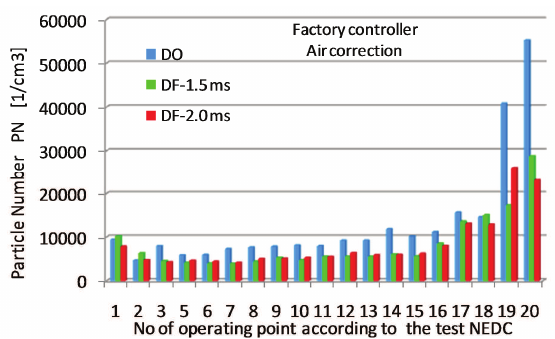
Fig 9. Comparison of total number of particulate matter (PN) in exhaust gases of Fiat 1.3 MJT engine fueled traditionally and in dual fuel system, with correction of air output: factory made ECU controller, constant opening time of gas injectors 1.5 ms and 2.0 ms